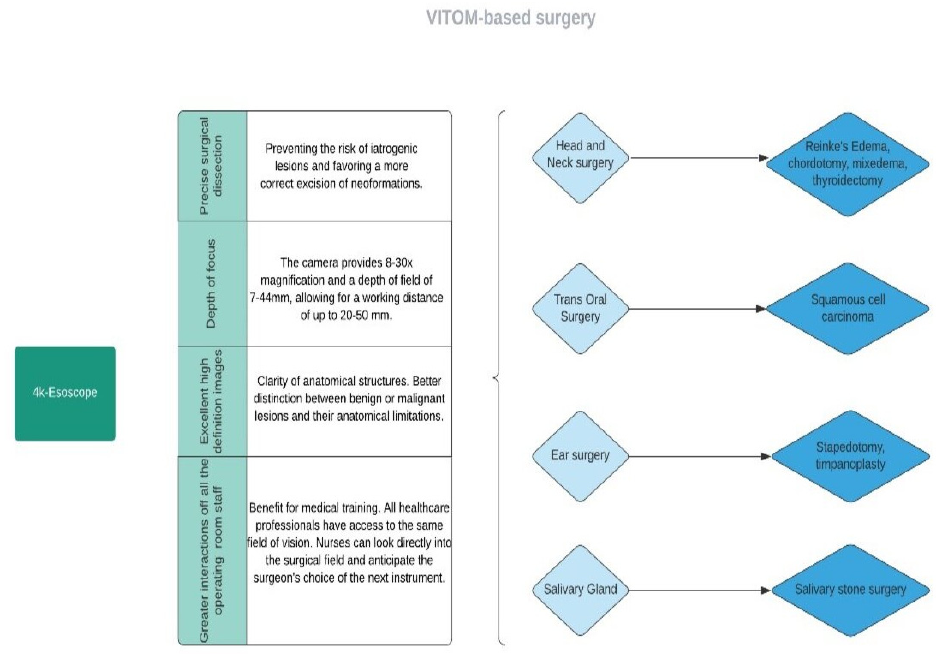
Figure 3. Flow diagram representing the main applications of exoscope-based